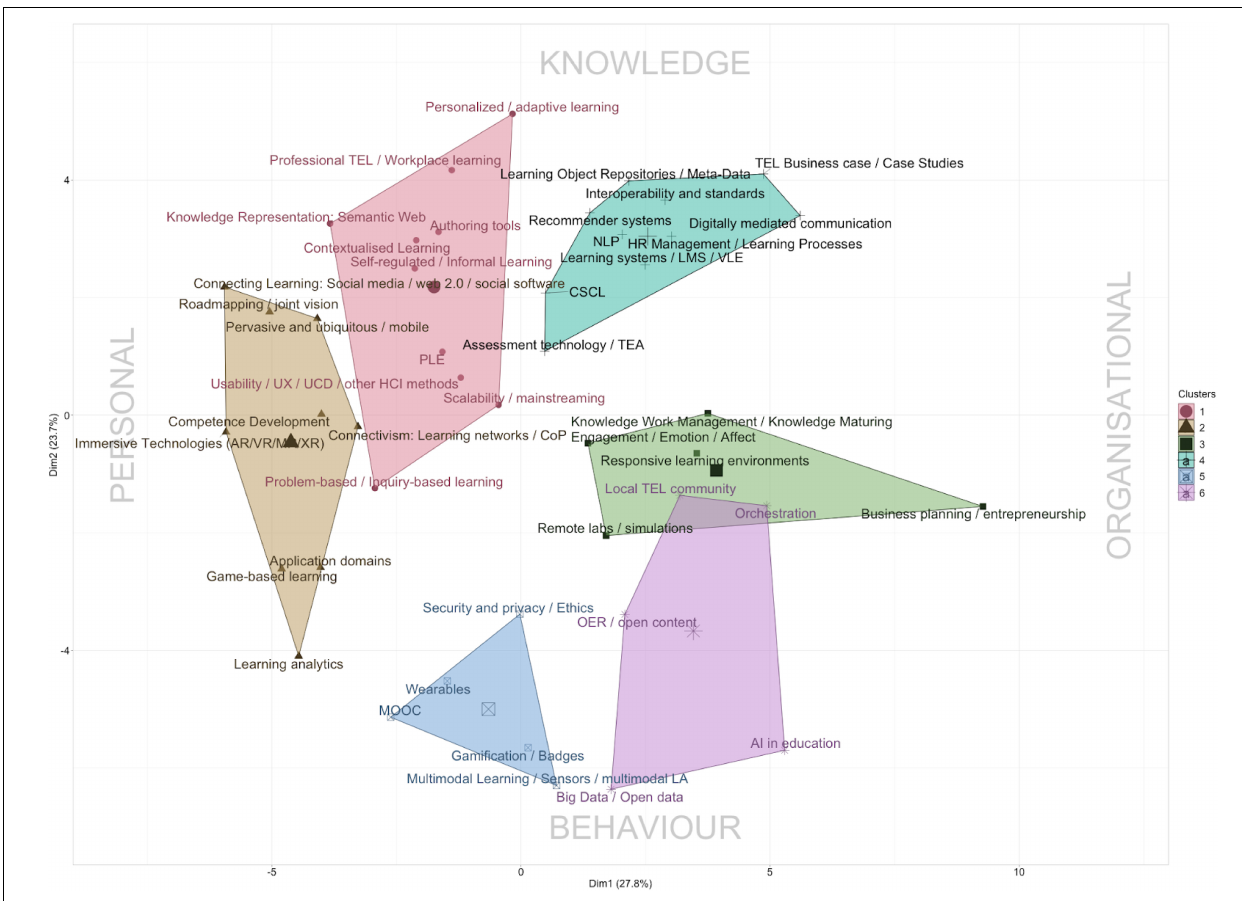
FIGURE 3 | Cluster plot of the session